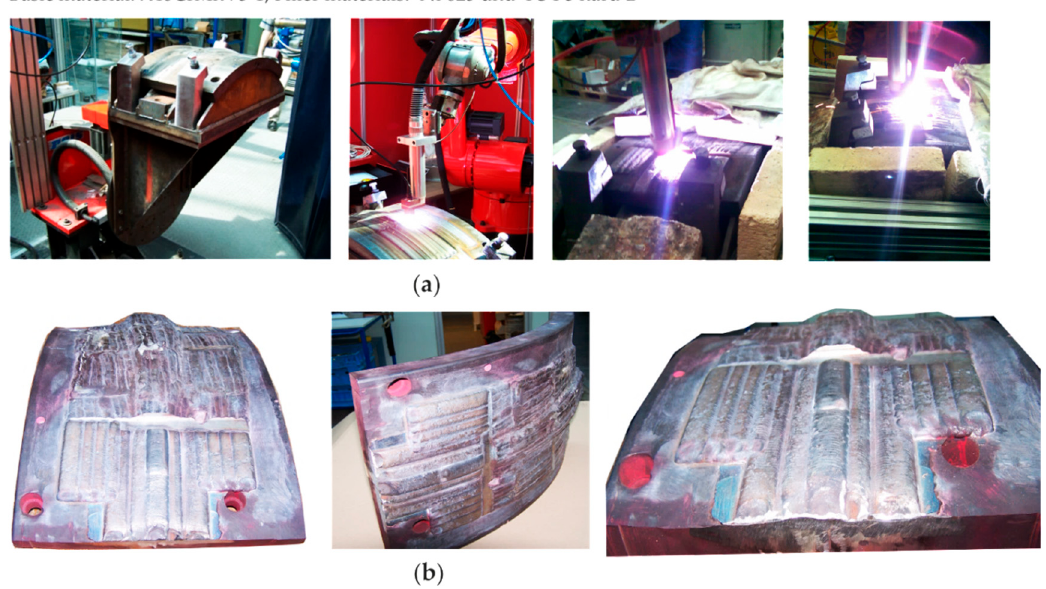
Figure 11. Additive 3DPMD technology: ( a ) build-up welded tool contours—1. segment of cross rolling tool and ( b ) welded tool contours after dye penetration test.